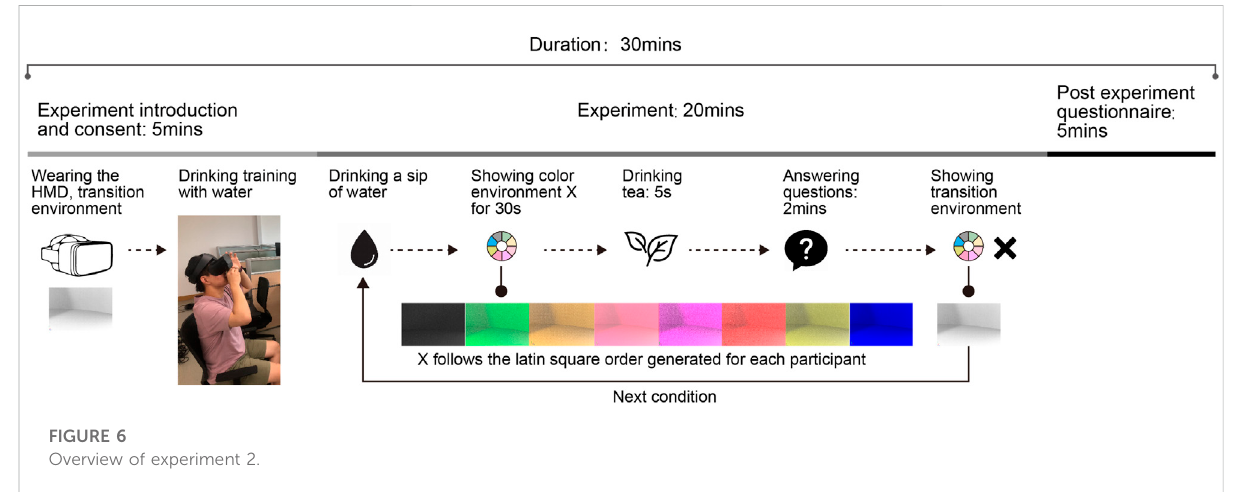
FIGURE 6 Overview of experiment